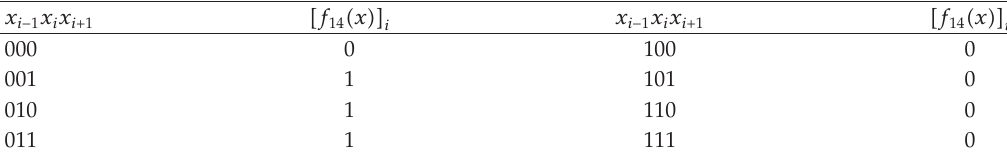
Table 1: The truth table of Boolean function of rule